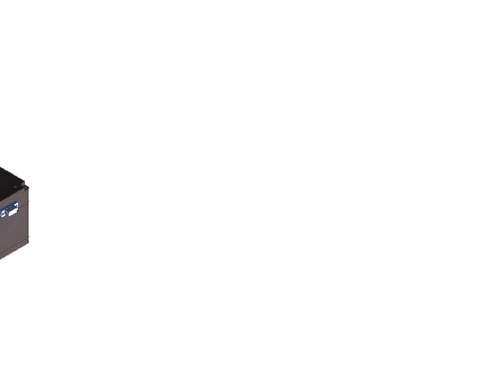
Figure 1. Conceptual Drawing of the Lunar Vehicle Radiation Dosimeter: a Particle Dosimeter and Spectrometer (PDS), a Tissue-Equivalent Dosimeter (TED), a Fast Neutron Spectrometer (NS-F), and an Epithermal Neutron Spectrometer (NS-E).